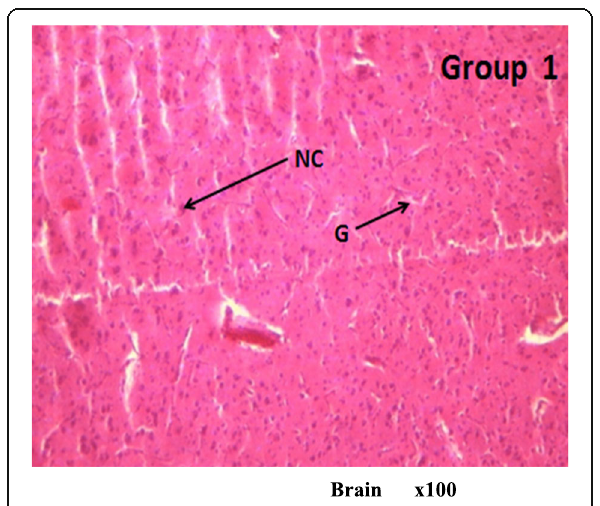
Fig. 9 Photomicrograph of the brain from a bird in group VII at the end of 12 weeks of direct exposure to 3 mg CN kg − 1 body weight. NCC, neuronal cell congestion